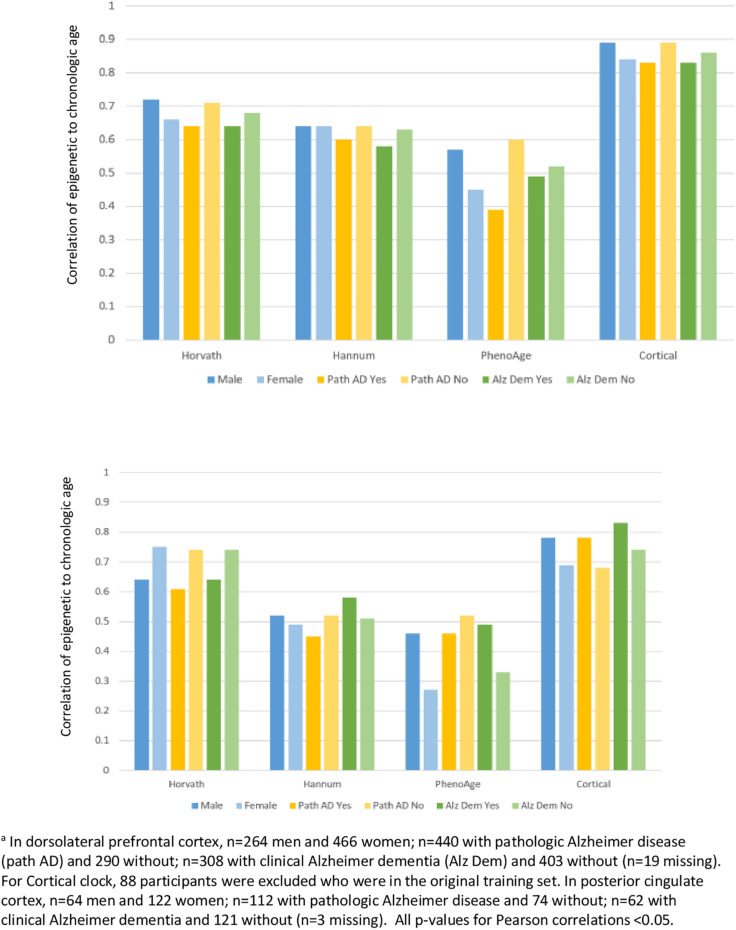
Pearson correlations of epigenetic age to chronologic age, according to characteristics of participantsa.